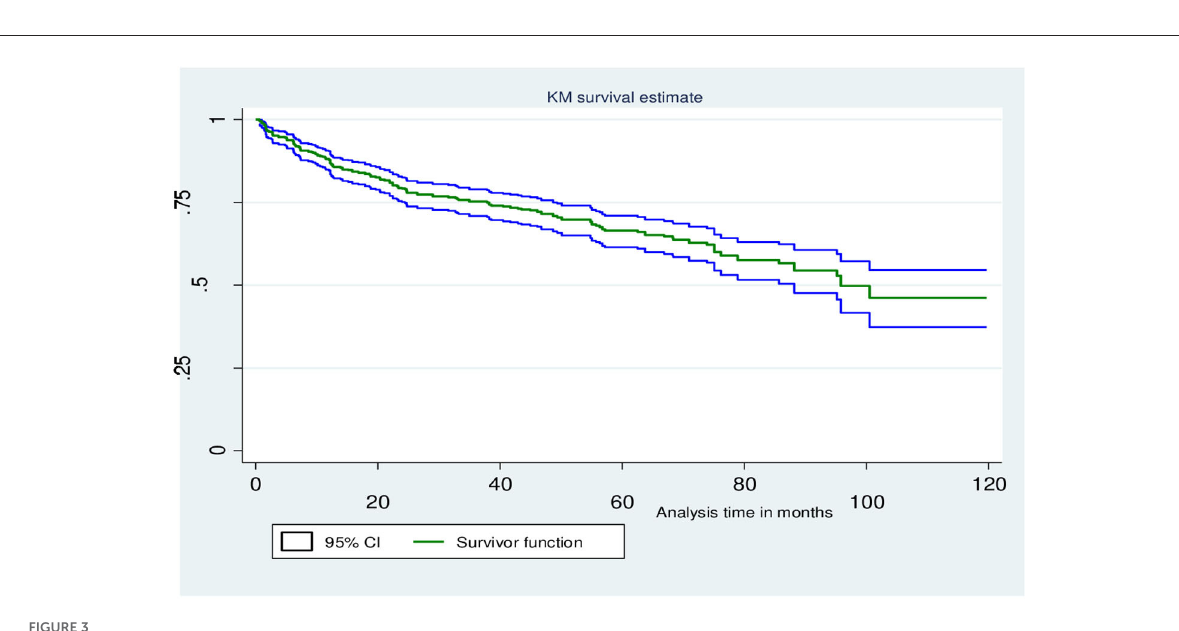
Pacific region (7.3 cases per 100 PYO) (34); multicohort analysis of persons infected with HIV in the United States and Canada, 2000–2010 (2.3 cases per 100 PYO)